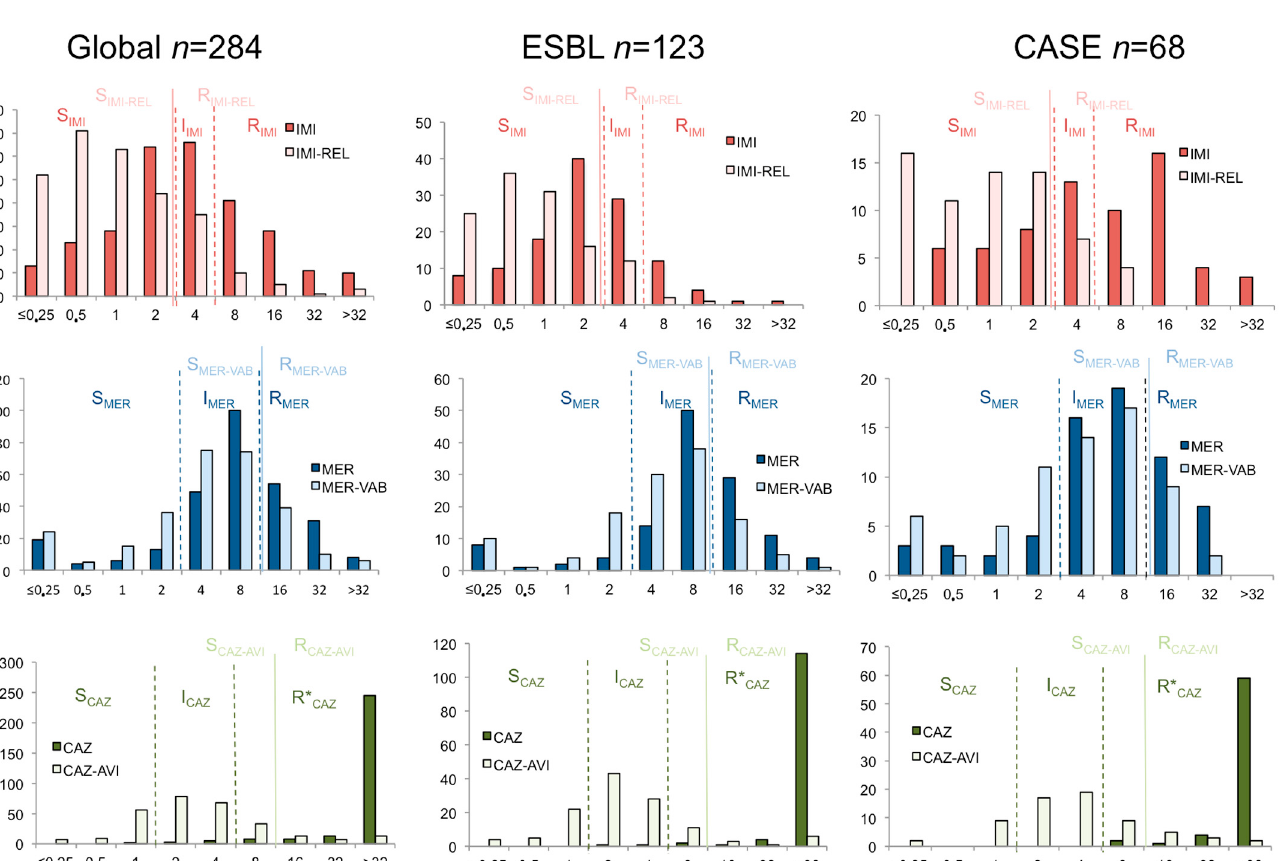
Red: Resistant; Green: susceptible according to EUCAST breakpoints.